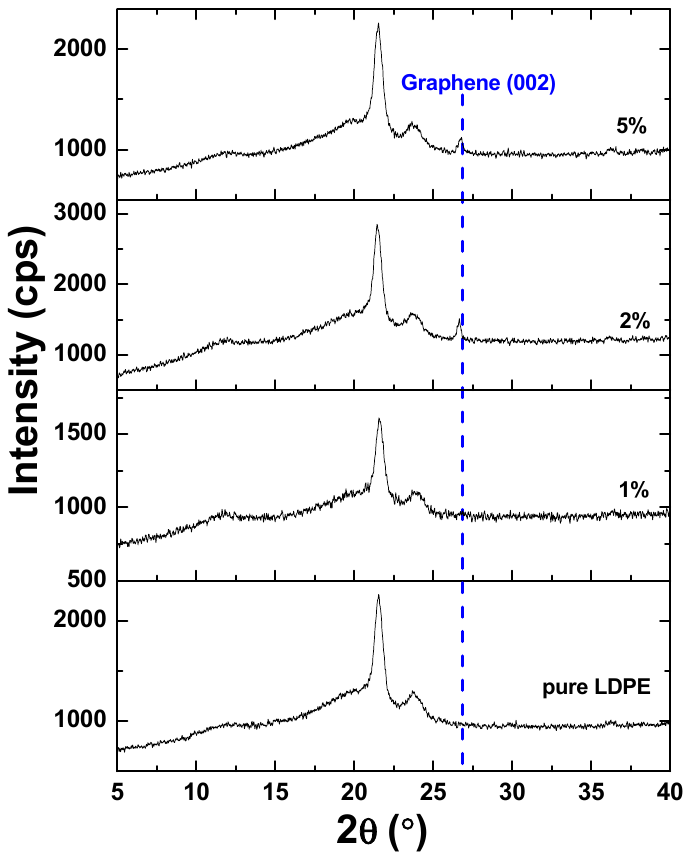
Figure 3. XRD patterns corresponding to pure LDPE and LDPE with different concentrations of graphene. The blue dashed line corresponds to graphene (002).